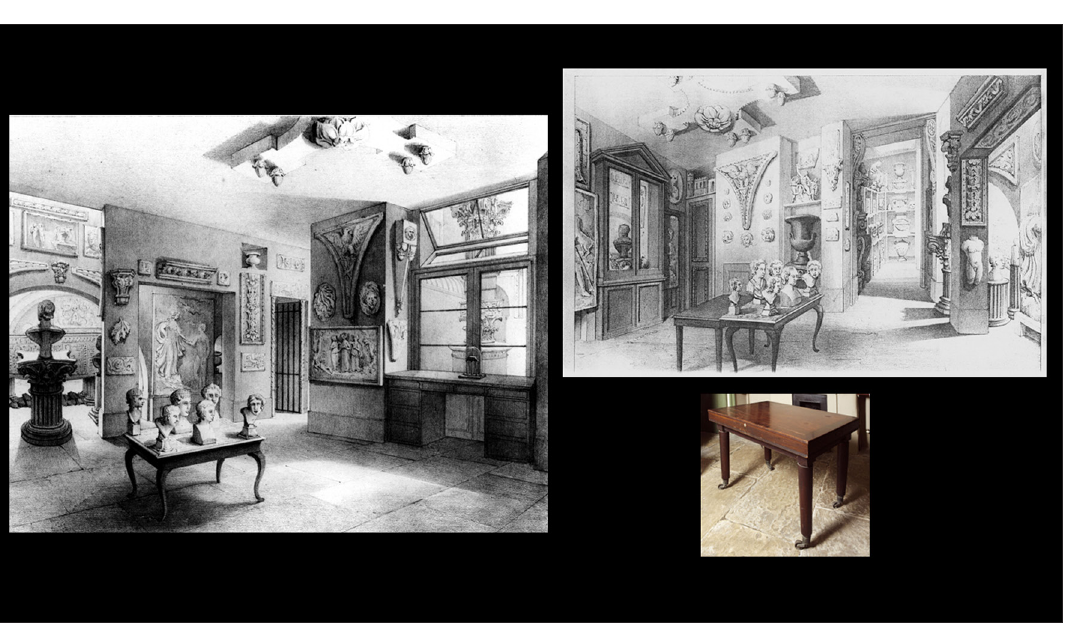
Fig. 9 : View of the basement Ante-Room, proof plate c. 1834 (not used), SM 60/8/192 (left);